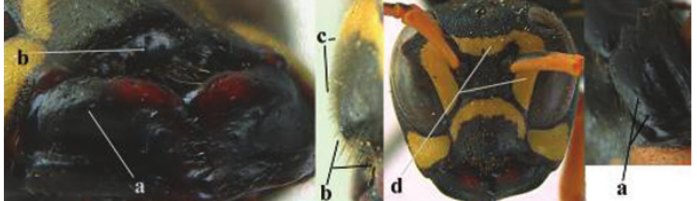
7 Dorsal ridge of mandible wide, convex and distinctly elevated above middle of mandible (a, b); fine pubescence of clypeus conspicuous and comparatively long (b, c); yellow area along inner eye margin usually connected with yellow bar above antennal sockets (d); SW and southern C Europe, N Africa; [= P. semenowi auctt.] ... P. austroccidentalis van Achterberg & Neumeyer, sp. n.